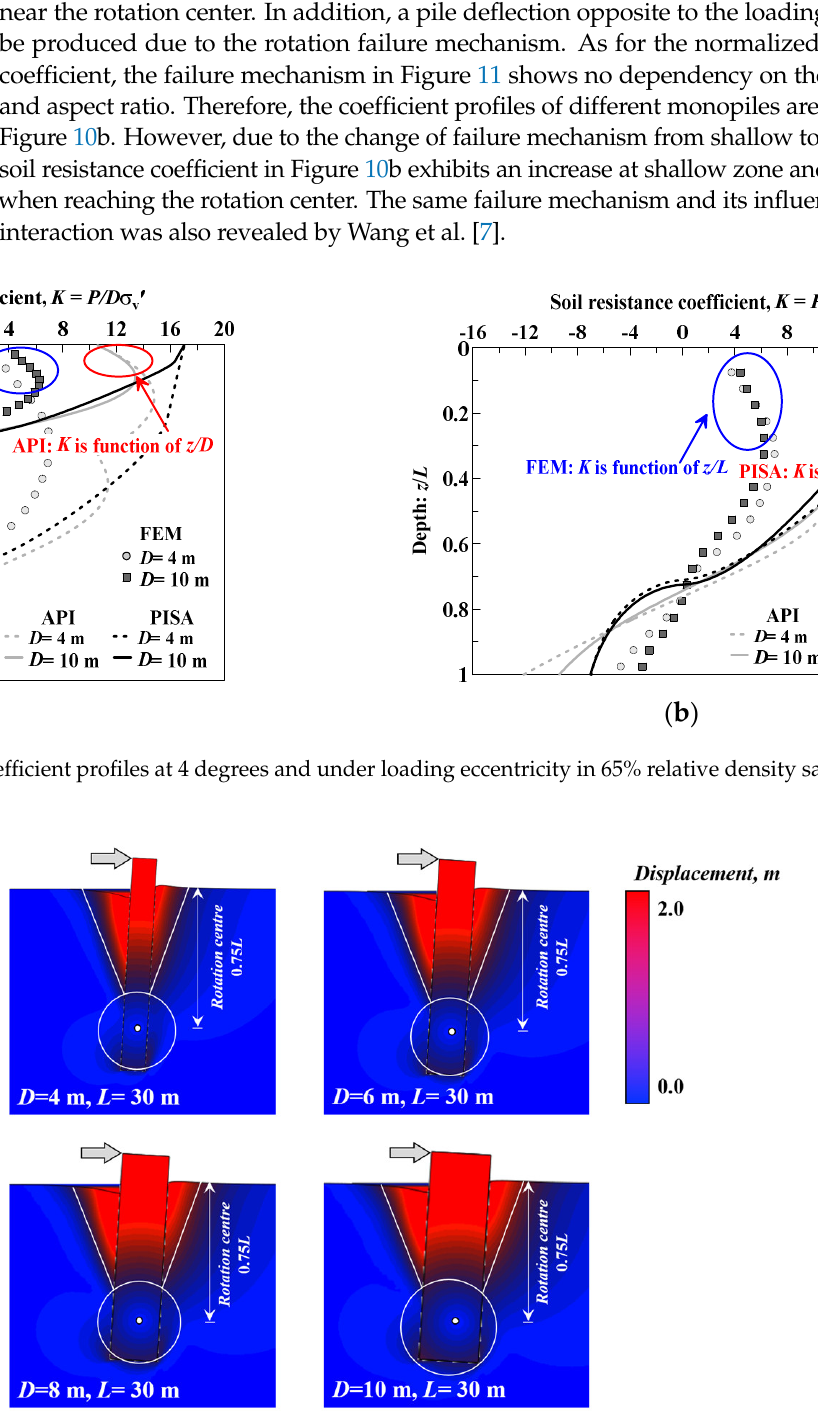
Figure 10. Soil resistance coefficient profiles at 4 degrees and under loading eccentricity in 65% relative density sand against: ( a ) z/D , ( b ) z/L.